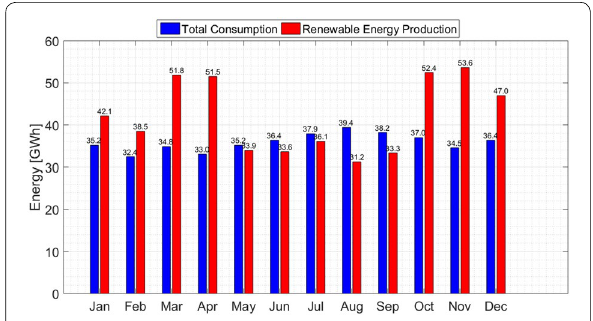
Fig. 8 Estimated total renewable energy emission and monthly